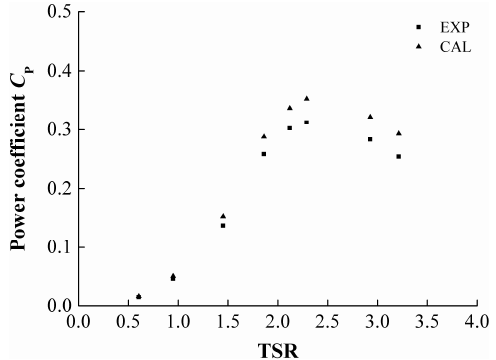
Figure 6. Comparison of calculation results and experimental data.